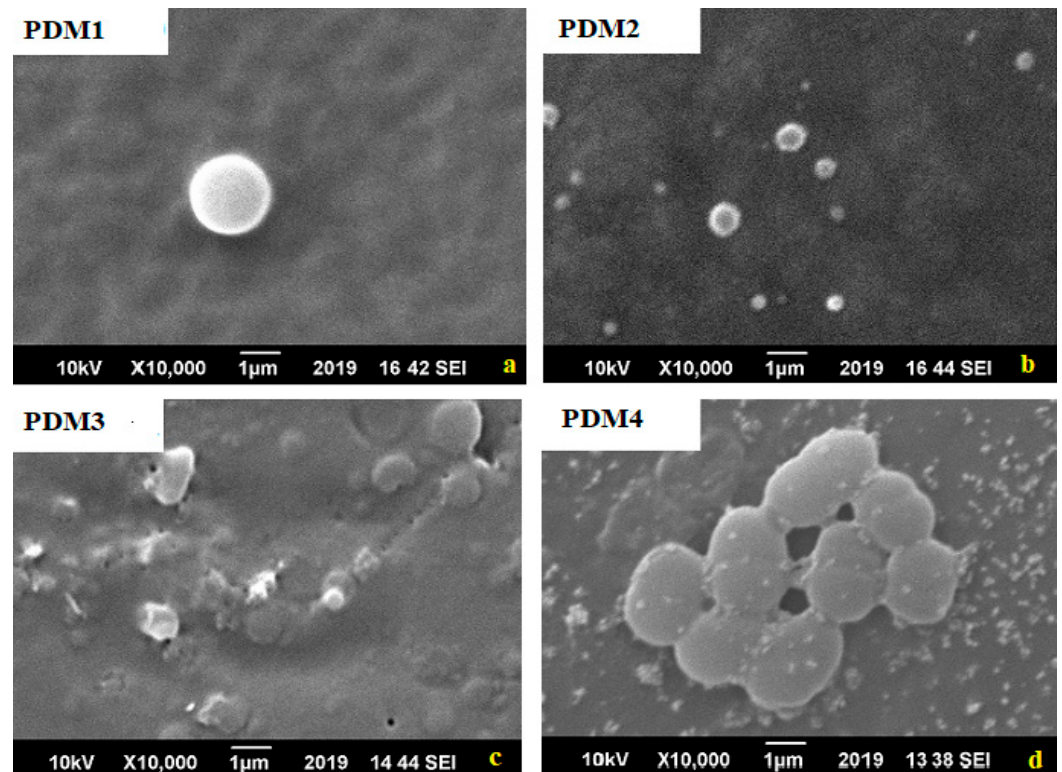
Figure 8. Scanning electron microscopy images for S. aureus that shows biofilm formation trend in copolymers: ( a ) PDM1; ( b ) PDM2; ( c ) PDM3; ( d ) PDM4.